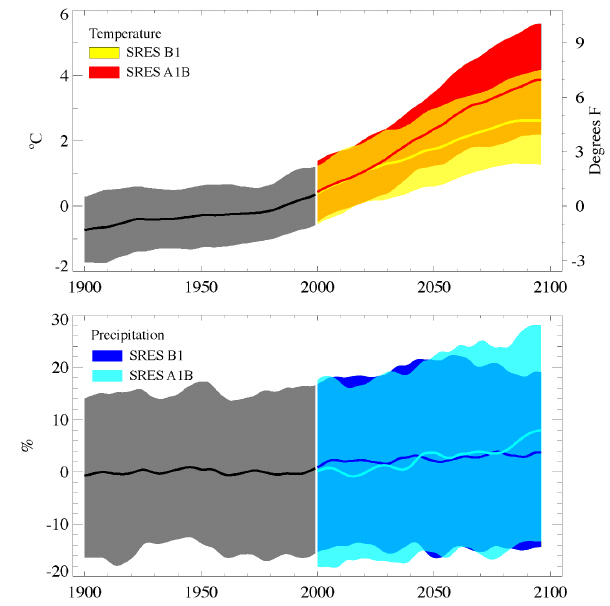
Figure 2. Summary of 20th and 21st century annual temperature and precipitation simulations from 20 GCMs over the PNW for two greenhouse gas emissions scenarios. Solid lines show the mean. The grey bands show the range (5th to 95th percentile) for the historical simulations, the colored bands show the range of future projections for each emissions scenario. Source: Mote and Salathé (2010).